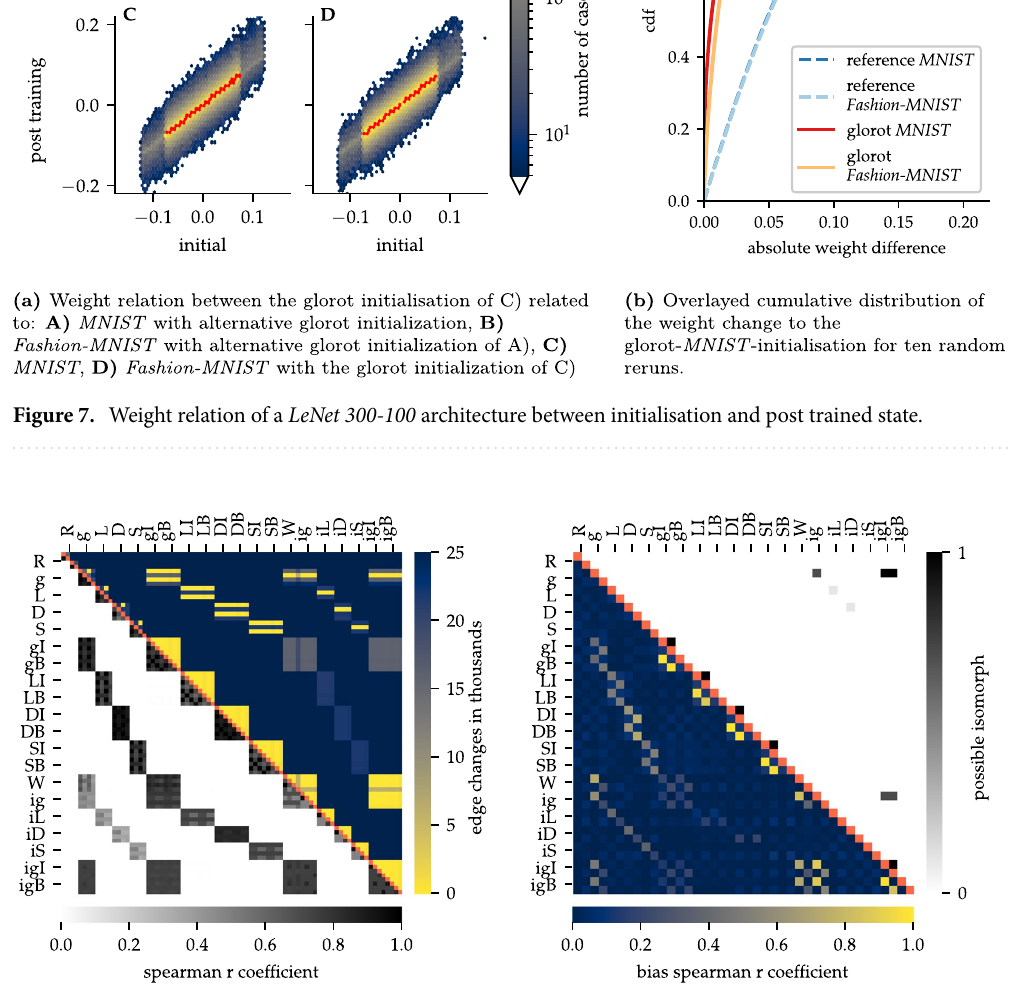
Figure 8. Demonstration of the two types of toast plots. Exemplary for the feed forward network LeNet 300-100 . The minimum distances for a 95% significance are based on t-test. The minimum distance for a 95% significance for the possible isomorphism is 0.9 based on binomial